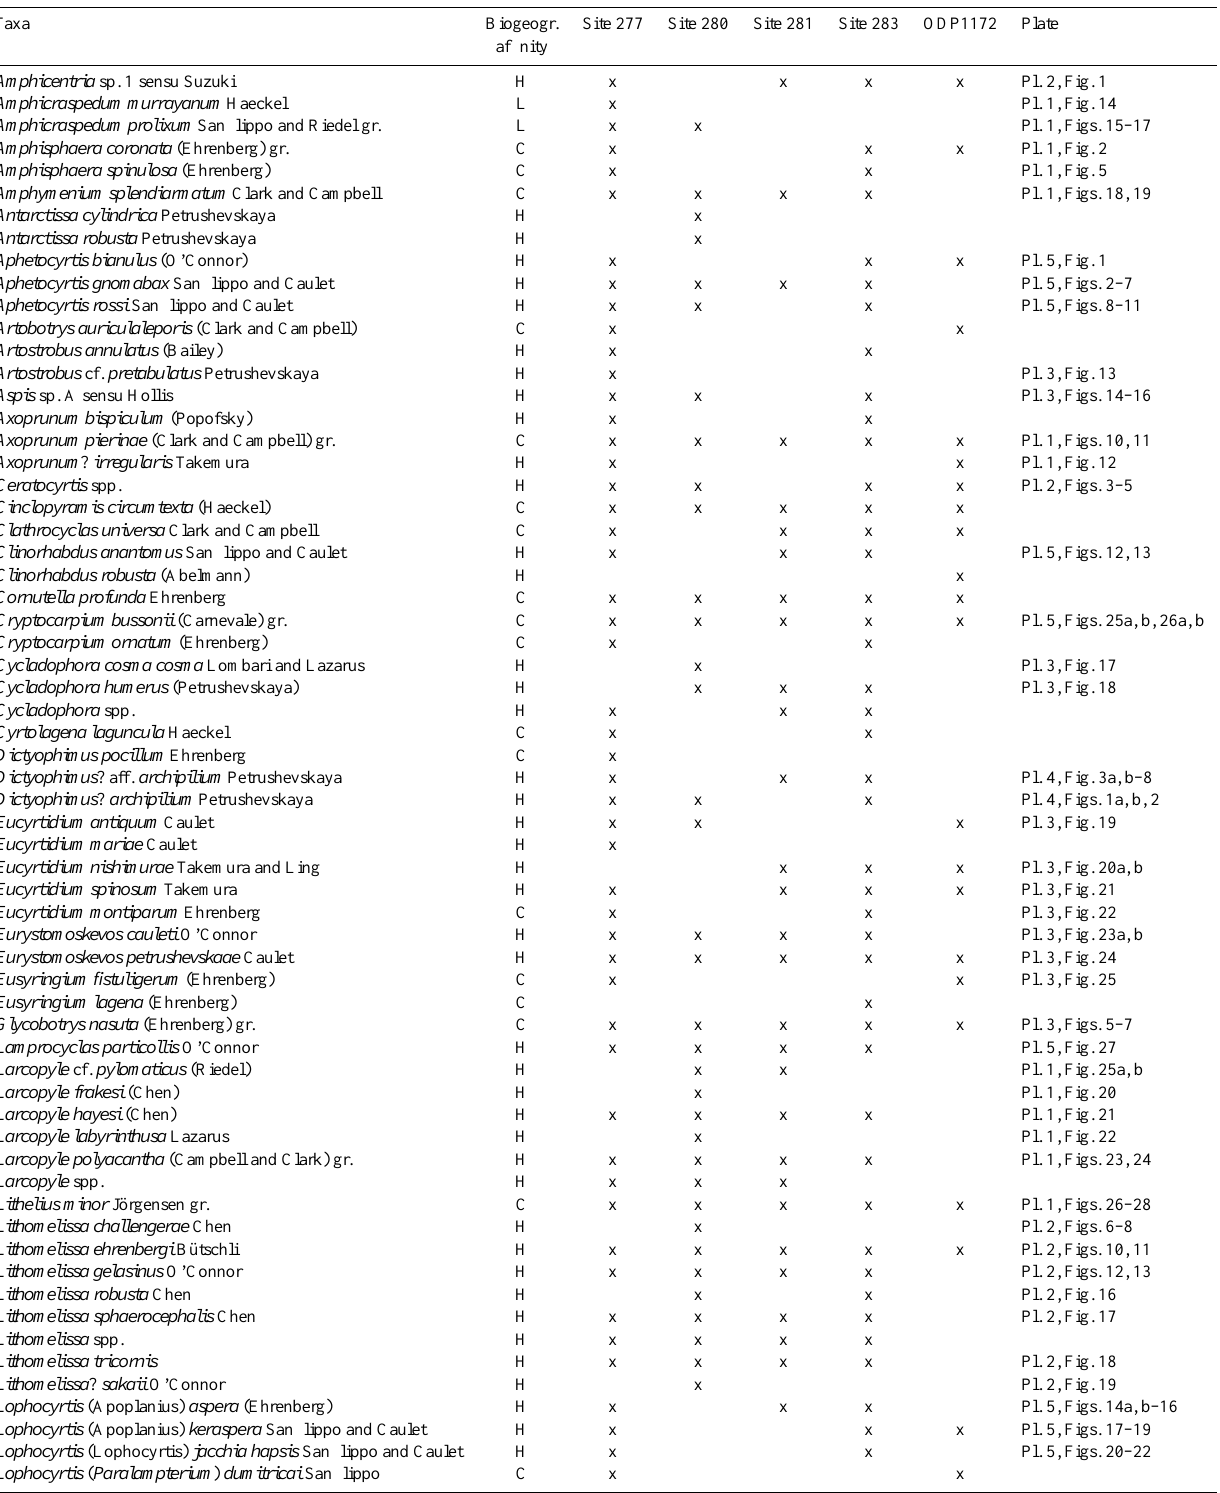
Table 1. Summary of species for which biogeographic affinities have been established and their presence (x) at sites 277, 280, 281, 283, and 1172. H: high latitude (>45 ◦ N/S); L: low latitude (<25 ◦ N/S); and C: cosmopolitan. Location of photographic images on plates for selected species.